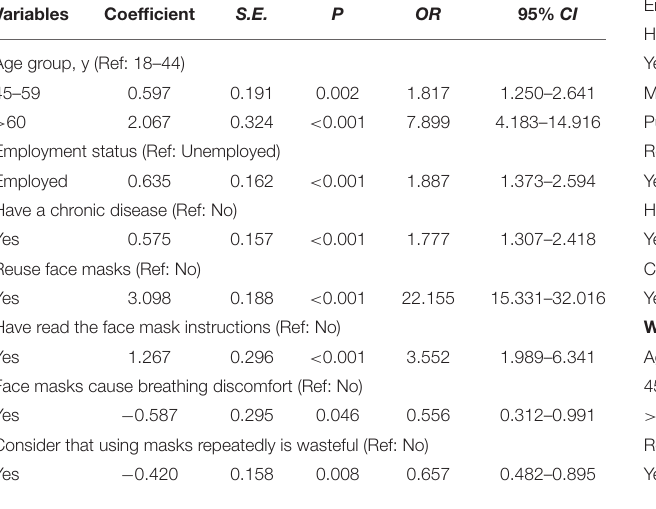
TABLE 3 | Mixed-effect logistic regression analysis on the influencing factors of the willingness of residents to use face masks in interpersonal communication during the Spring Festival.